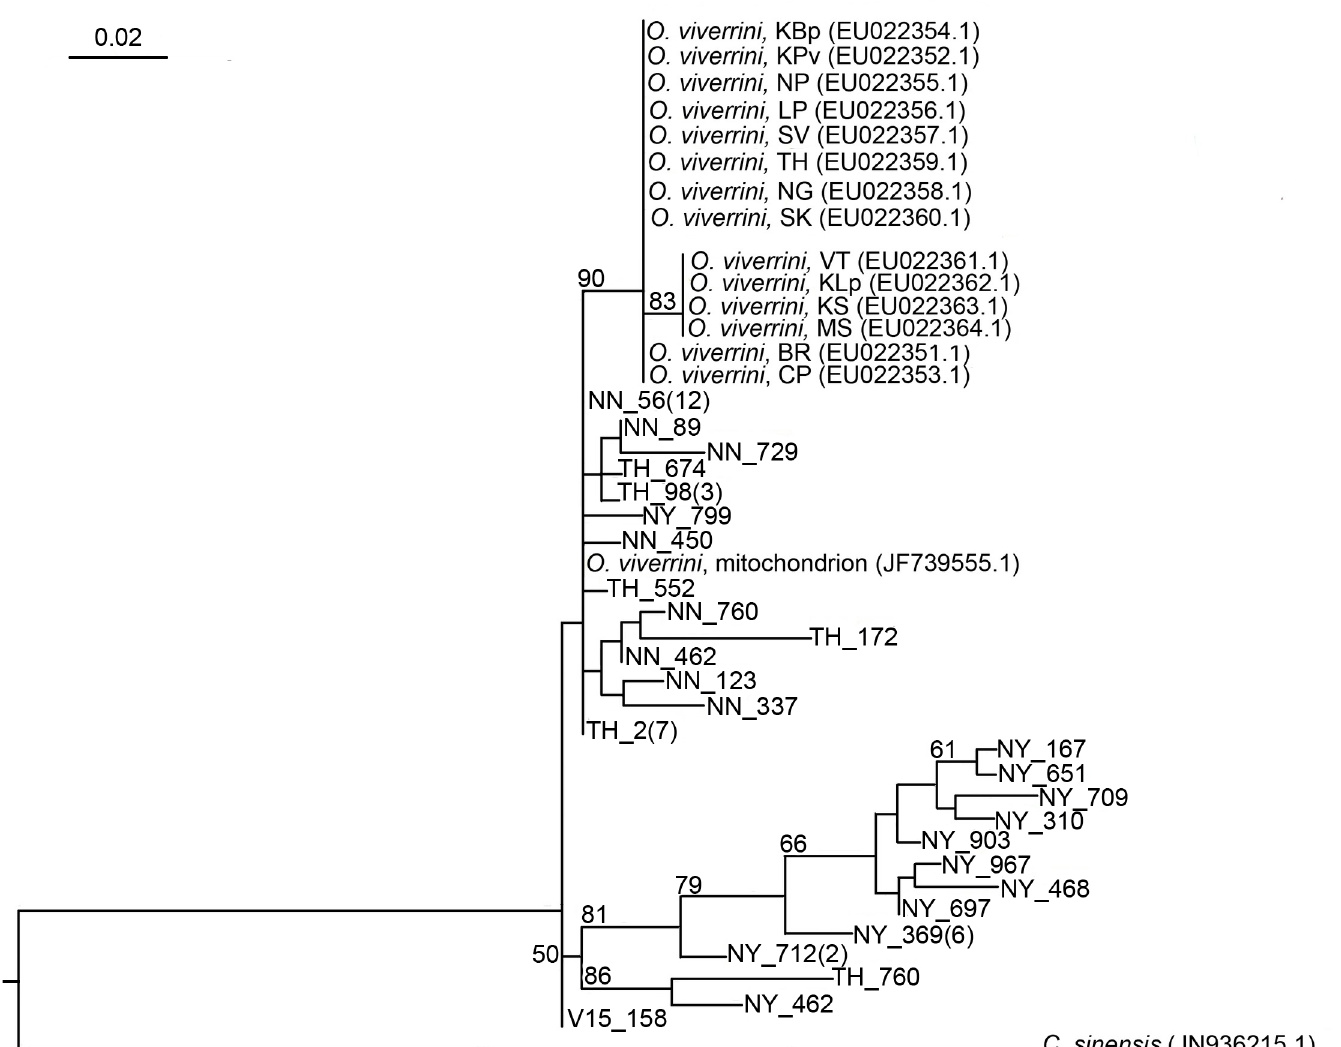
Fig 4. The Randomized AxeleratedMaximum Likelihood tree based on the cox1 sequences of O . viverrini . The alignment of 393 nucleotide sequenceswithout gaps and 27 variants from three villages(NY = Na-Yao, NN = Na-Ngam,TH = Thoong-Heang) were analyzed. O . viverrini Thai isolates (CP, BR, KBp, KPv, SK, NG, MS, KLp, KS) and Lao PDR isolates (SV, VT, O . viverrini mitochondrion partial genome)were used as the reference isolates. The percentages of 1,000 replications (bootstraps) of more than 50% are shown at the nodes. The number of samples is in